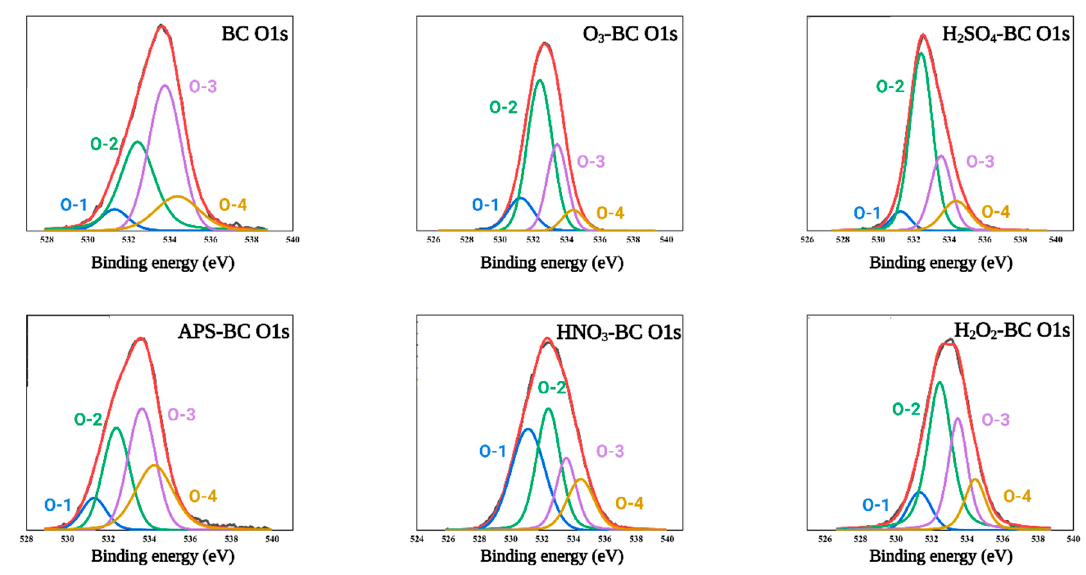
Figure 4. Deconvolution of O1s spectra for all the biochar samples. O-1: carbonyl and quinone; O-2: esters and anhydrides; O-3: ether-type oxygen in esters and anhydrides; and O-4: carboxylic oxygen. Table 6. Relative contents of O1s peaks in biochar samples obtained by XPS spectra.